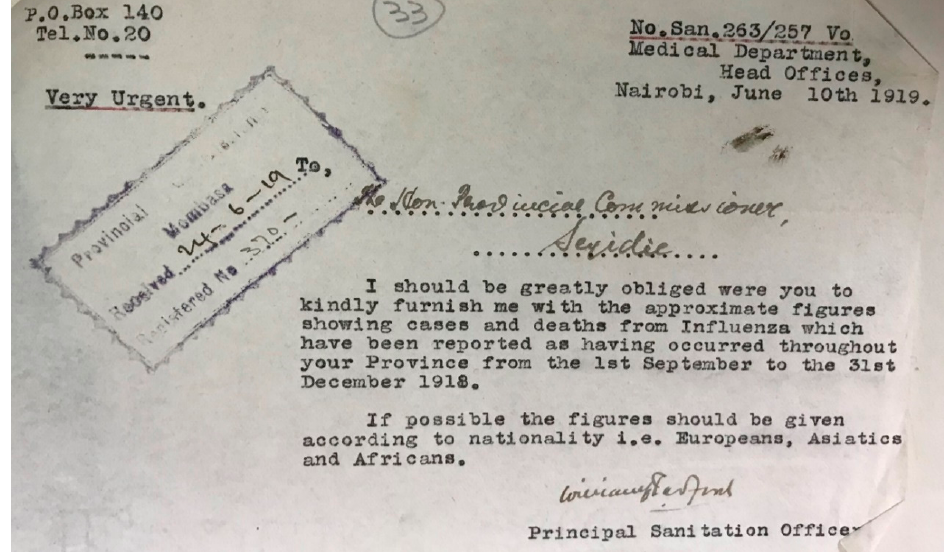
Figure 2. Coast Province administration last letter sent to one of the District Officers requesting the 1918 pandemic influenza cases and deaths. (Source: National Archives Library-KNA, Nairobi Kenya).